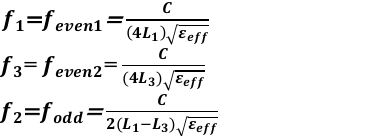
FIGURE 2. Frequency response of Tri Mode resonator